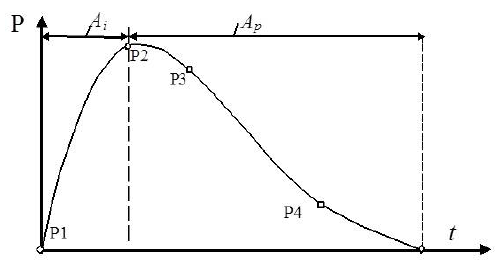
Figure 6. Structural-energetic stress-time curve for steel 17G1S: is micro-level of loss of shear stability (crack P − P 1 2 initiation); P is the crack − P 2 4